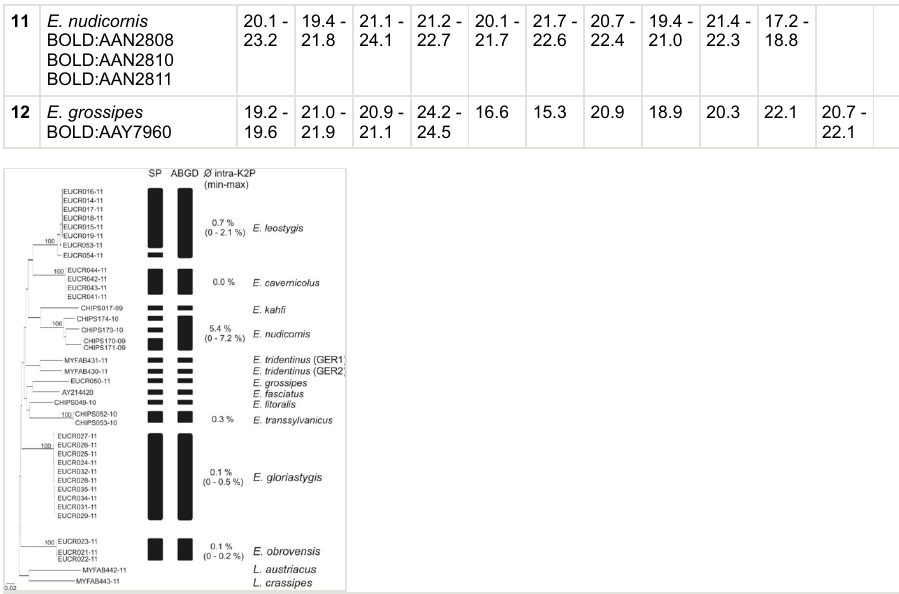
11 E. nudicornis BOLD:AAN2808 BOLD:AAN2810